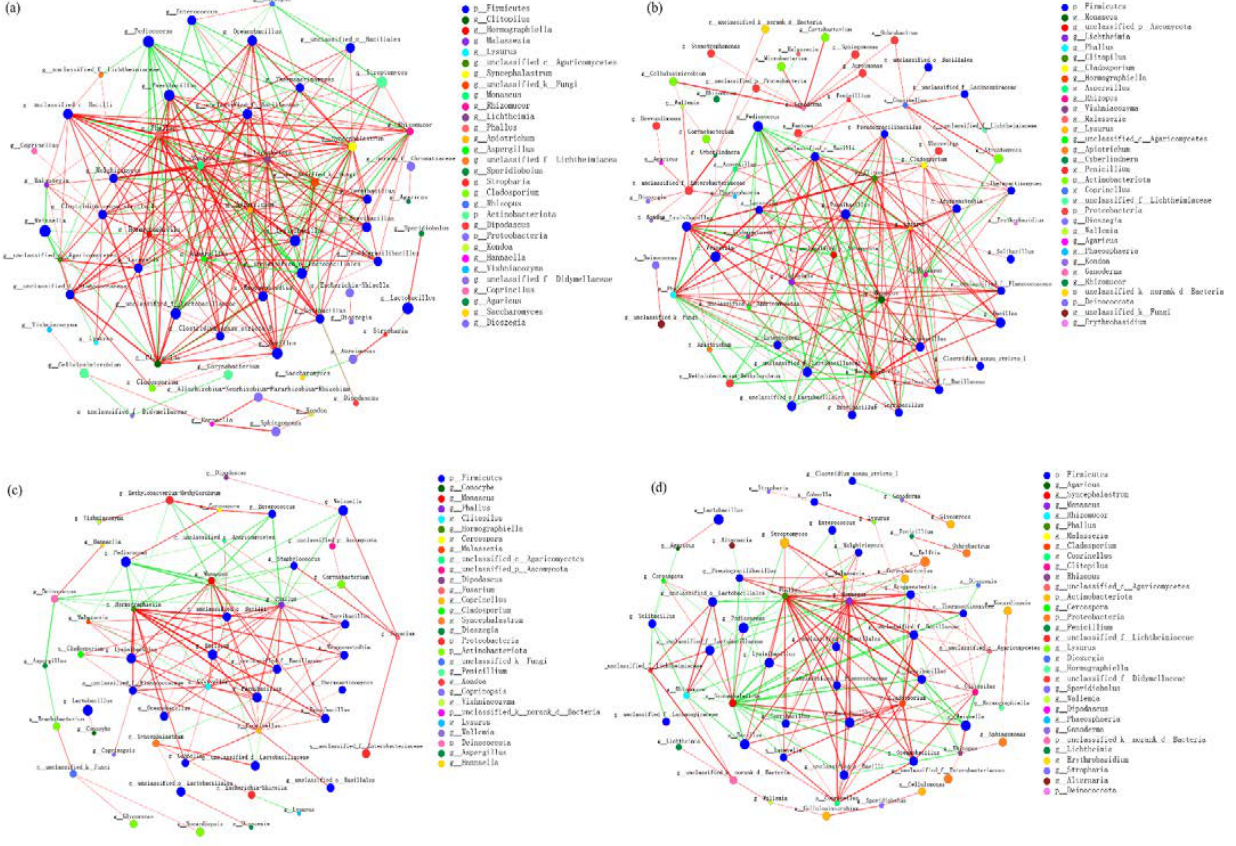
Figure 10. Co-occurrence network of fungal and bacterial communities during silage fermentation.